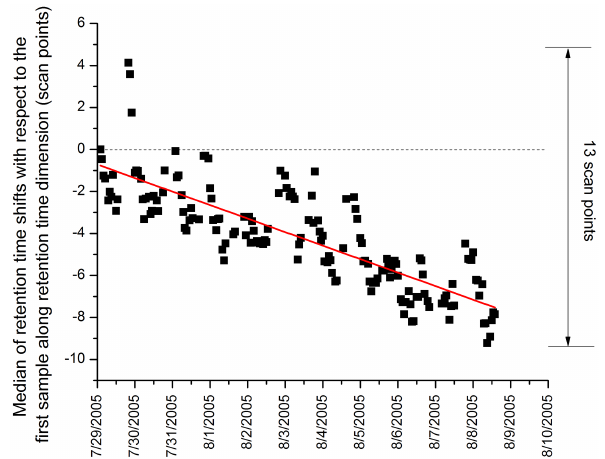
Figure 4. The difference of Pearson r values obtained with reten- tion time shift correction subtracted from values obtained with no retention time shift correction, of TAG–Bin HOA (OOA) time series compared to AMS HOA (OOA), and CO (O x ) time